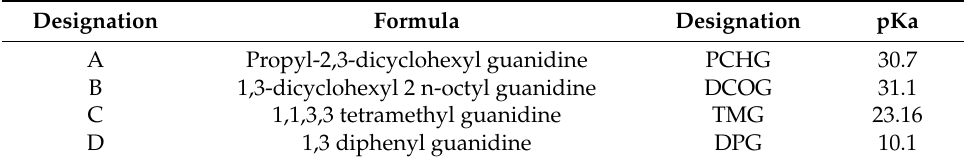
Table 1. Designation of the guanidines used as catalysts.